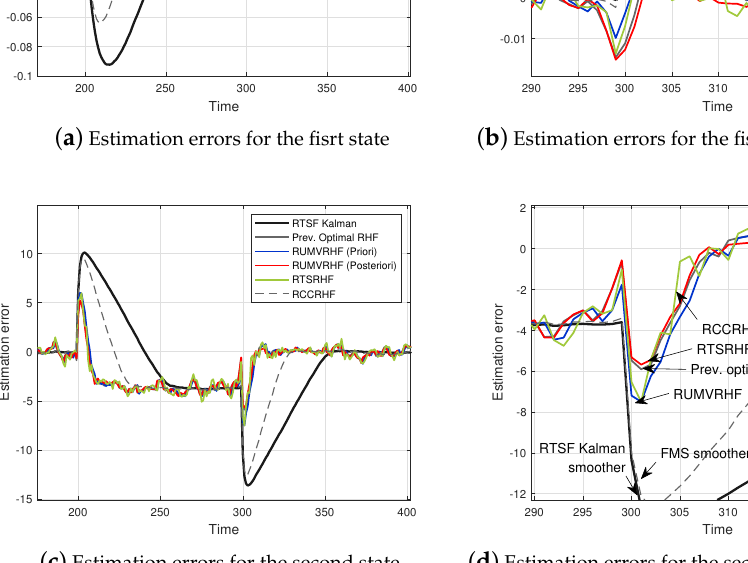
( d ) Estimation errors for the second state (enlargement)